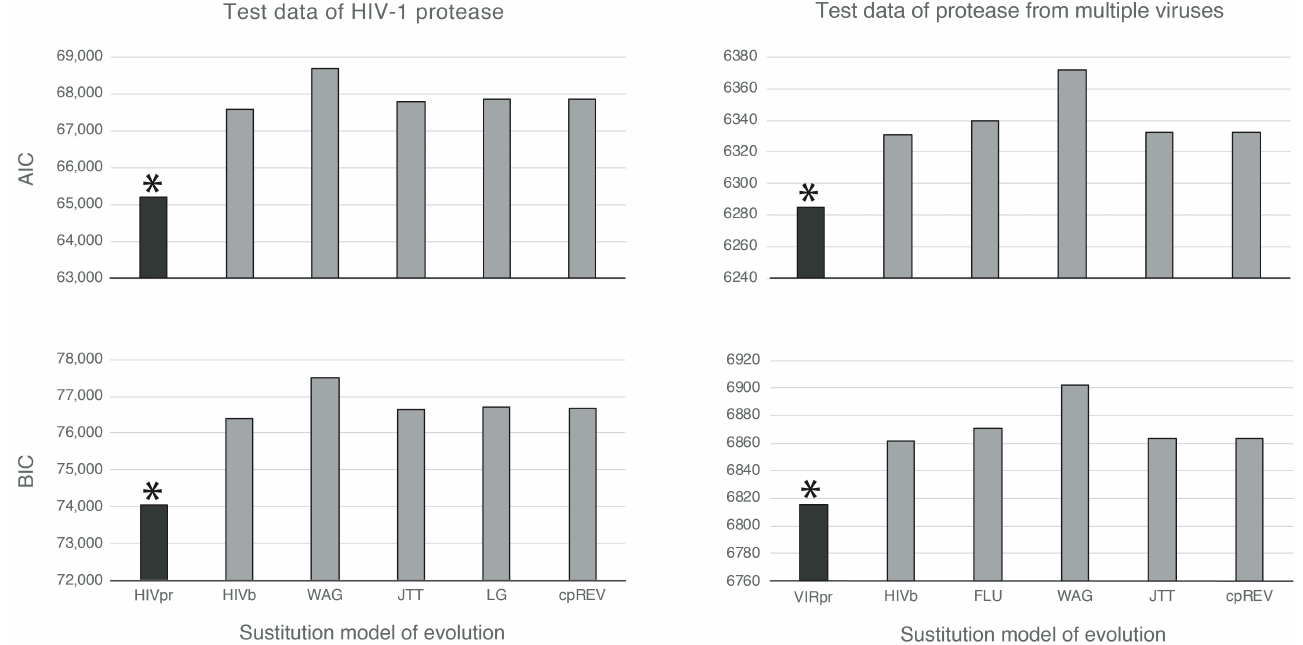
Figure 3. Likelihood-based evaluation of the HIVpr, VIRpr and currently available best-fitting substitution models. For the HIV PR (left plots) and viral PR (right plots) test datasets, the plots show the AIC (top plots) and BIC (bottom plots) scores obtained with the HIVpr and VIRpr substitution models inferred in this study and the top five currently available best-fitting substitution models with the corresponding test dataset. In all of the cases, the models developed in this study produced AIC and BIC scores (black bars) significantly lower than the currently available best-fitting substitution models ( p -values = 0.00013 and 0.00014 for HIVpr and VIRpr, respectively and illustrated with * in the